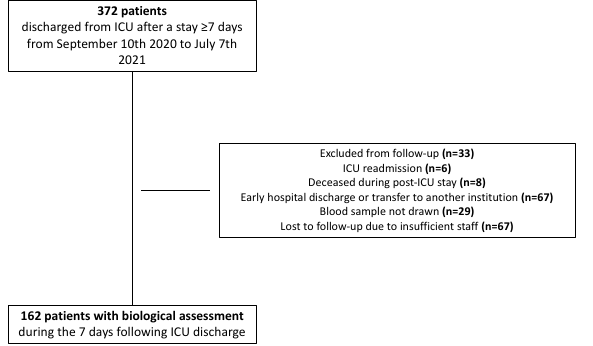
Figure 1. Flow chart. Table 1. Cohort demographics.